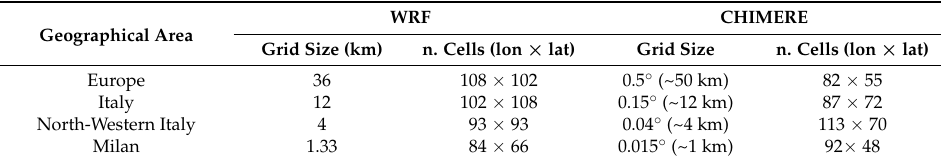
Table 1. Grid size and number of cells of simulation domains of Weather Research and Forecasting and CHIMERE models.